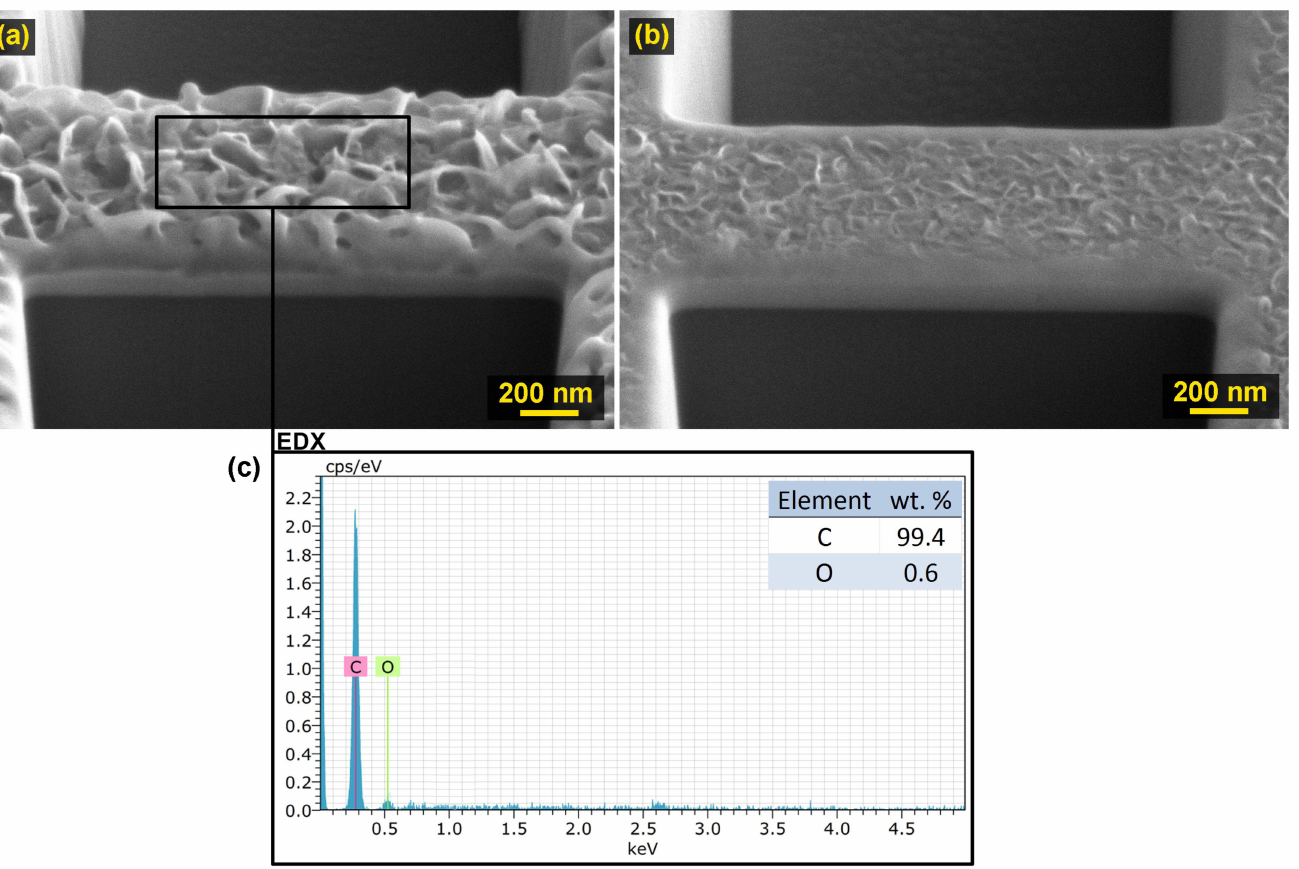
Figure 1. ( a ) section of Sample 50 and EDX analysis on the marked area (SEM/SE), ( b ) section of Sample 1, where the vertical graphene did not grow at all (SEM/SE), ( c ) EDX